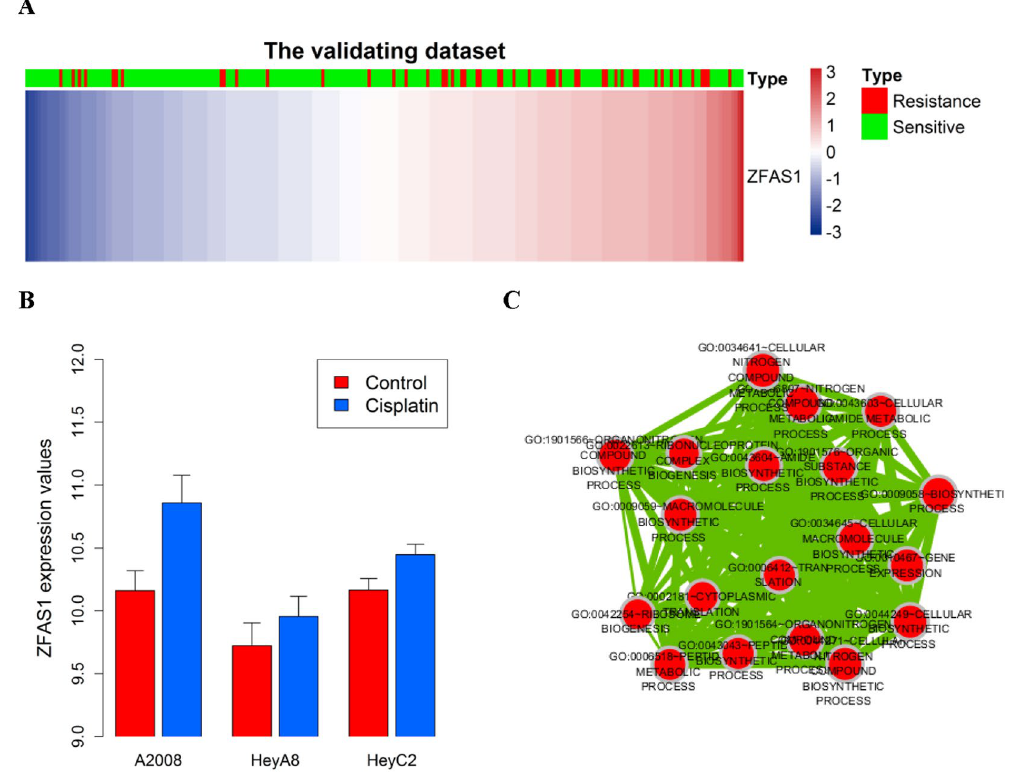
Figure 3. Associations between ZFAS1 and chemosensitivity are observed in the validating datasets. Heatmap based on the genes (rows) of patients with ovarian cancer (columns) for the ZFAS1 in the validating dataset ( A ). Red and blue indicate high and low expression levels, respectively. The expression values of ZFAS1 in A2008, HeyA8, and HeyC2 cell lines treated with or without cisplatin treatment. p values were calculated by independent two-tailed t test. Error bars represent the mean ± SD ( B ). The functional map of enriched GO terms with each node indicates an enriched GO term, and each edge represents the common genes shared between connecting and enriched GO terms ( C ).